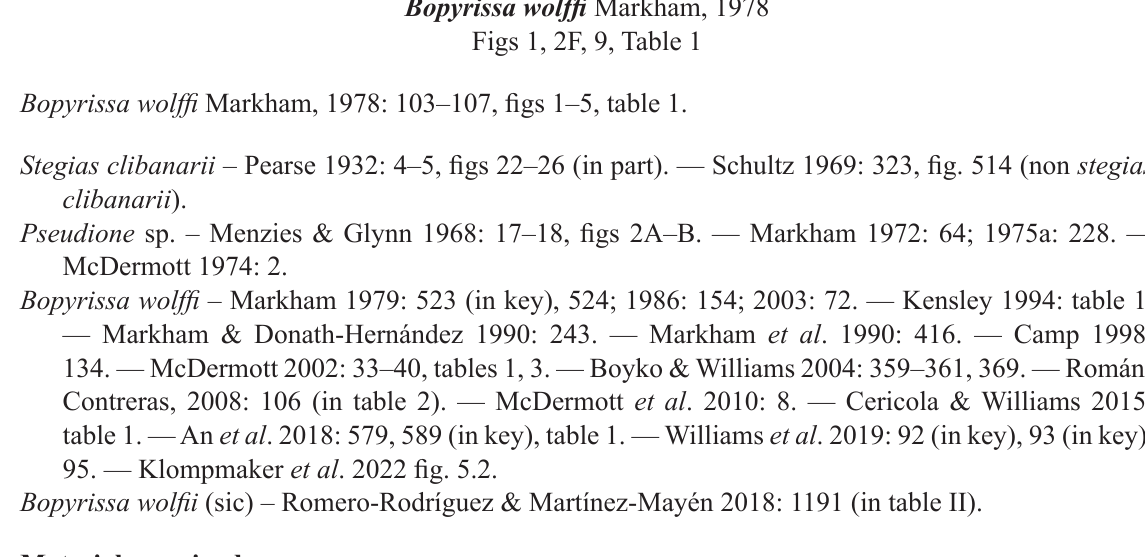
table 1. — An et al . 2018: 579, 589 (in key), table 1. — Williams et al . 2019: 92 (in key), 93 (in key), 95. — Klompmaker et al . 2022 fig.